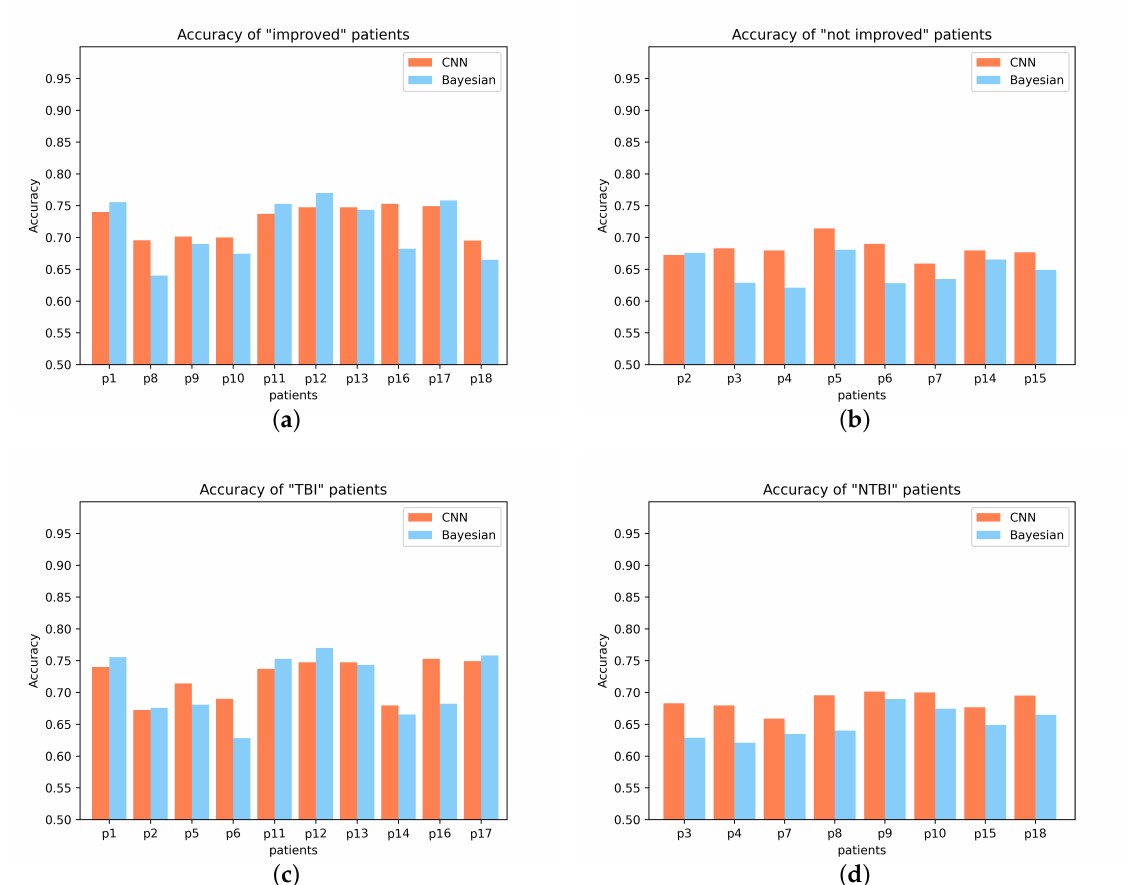
Figure 2. Upper panel: ( a , b ) represent the P300 detection accuracy of “improved” patients and “not improved” patients, respectively; ( c , d ) represent the P300 detection accuracy of TBI patients and NTBI patients,